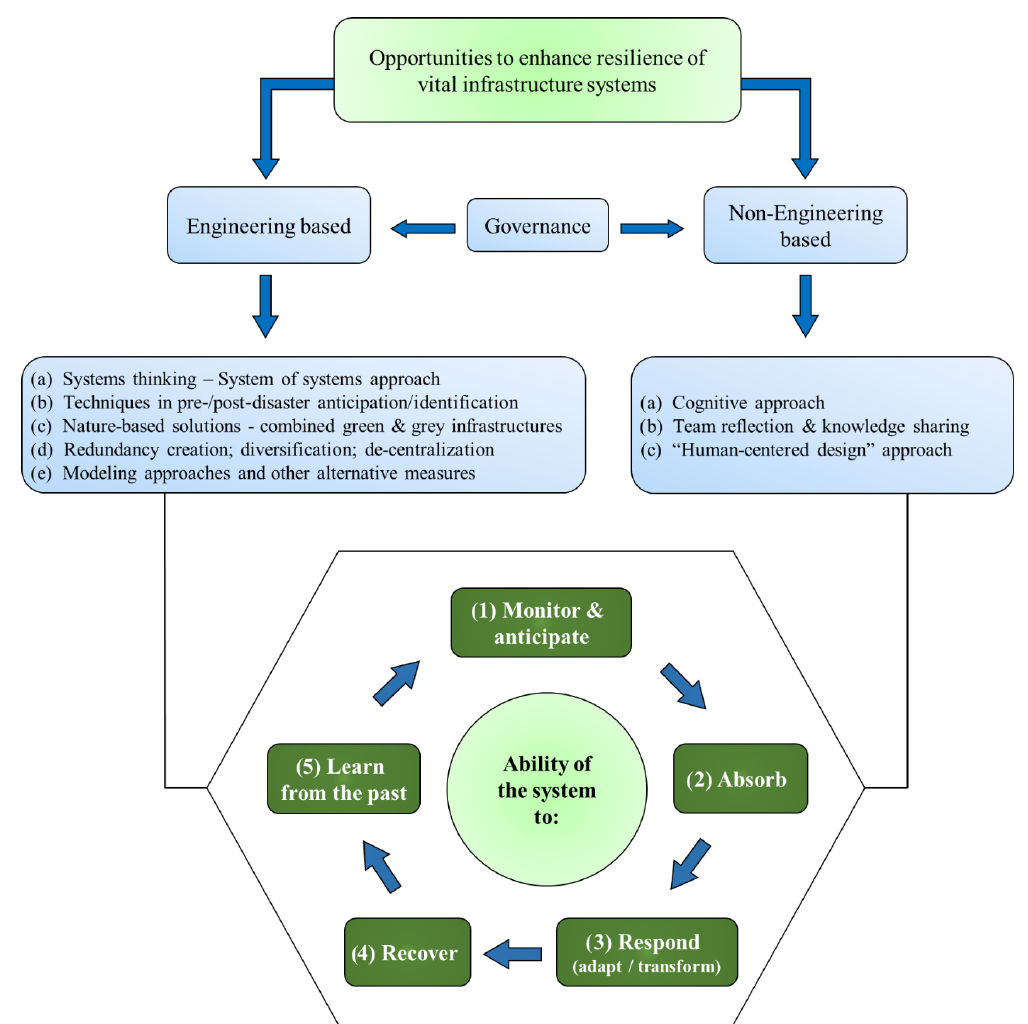
Figure 4. Main engineering-based and non-engineering-based opportunities and measures to improve the five main system capabilities required for a resilient vital